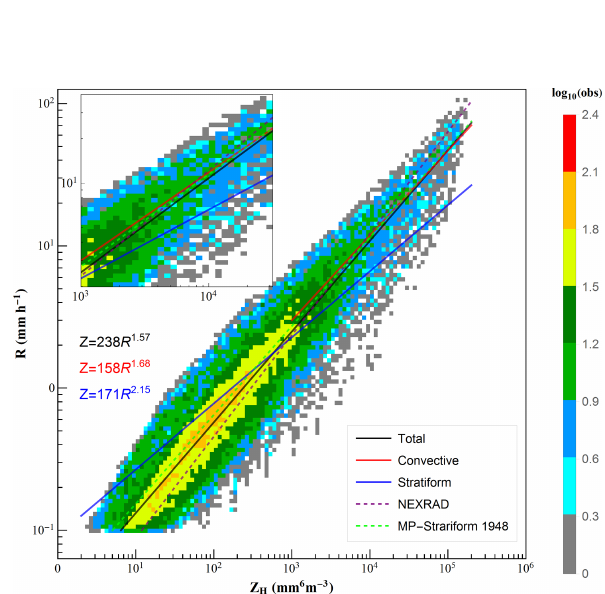
Figure 11. Same as Fig. 6 but for different months.